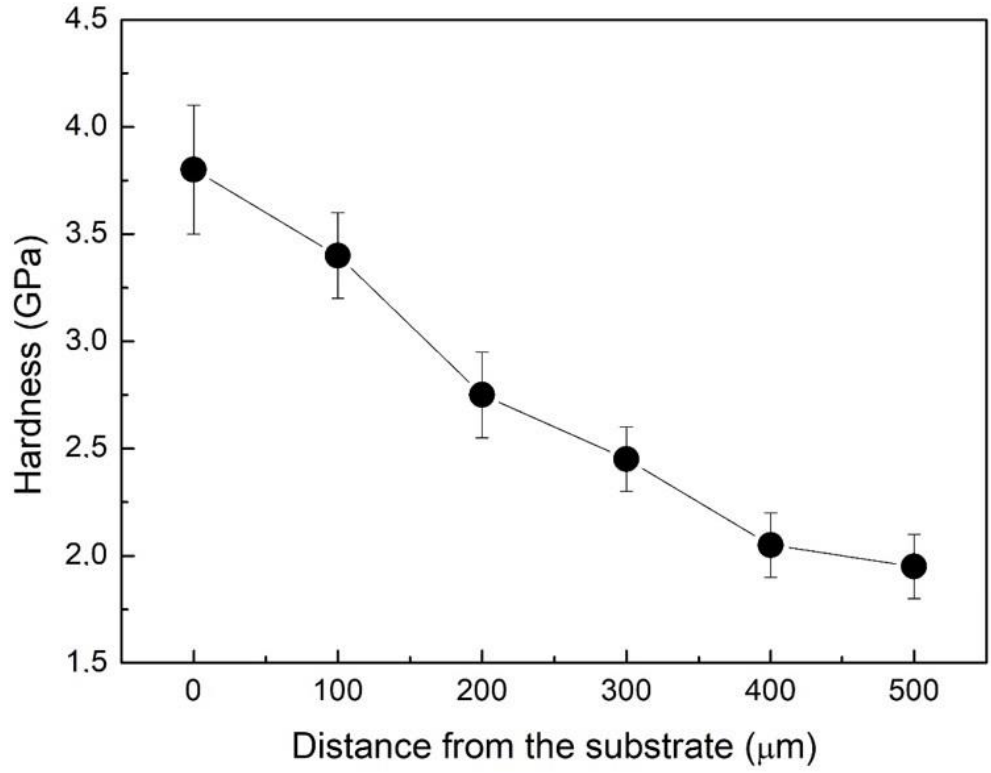
Figure 8. Hardness profile of the studied